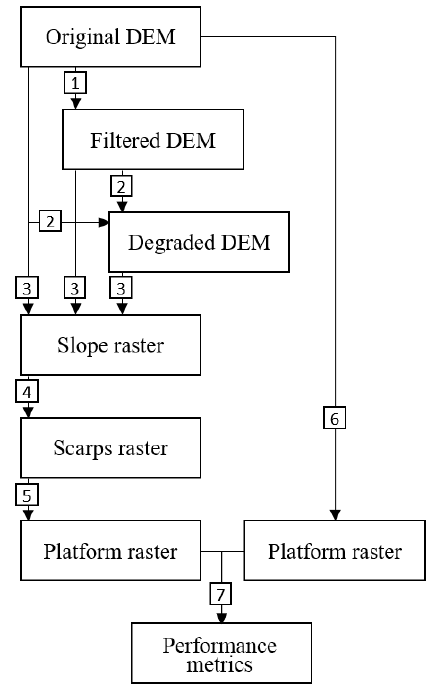
Figure 1. Flow chart showing the overall structure of the TIP method and its validation. Each object (rectangle) is obtained by im- plementing a routine (square), numbered as follows: 1. implemen- tation of a Wiener filter (optional); 2. subsampling by average value (optional); 3. calculation of slope by fitting a second-order polyno- mial surface; 4. scarp identification by routing; 5. platform identi- fication by dispersion; 6. manual digitisation of a marsh platform; 7. comparison of the objectively detected platform to the manually digitised